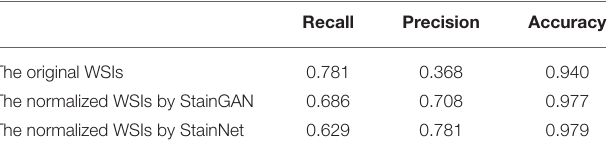
TABLE 5 | The recall, precision, and accuracy of the metastasis detection at the WSI